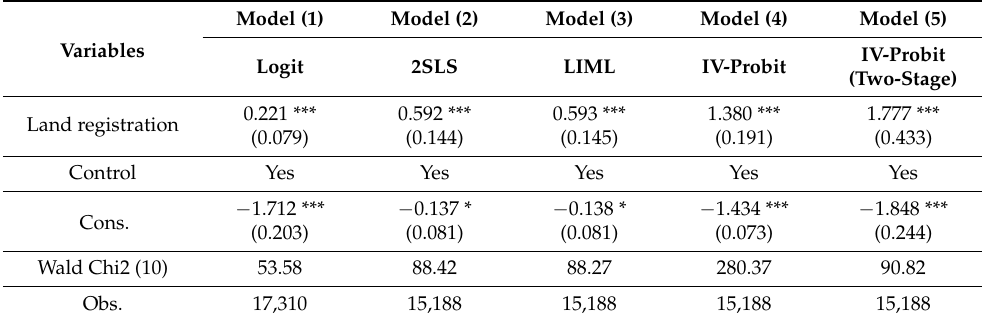
Table 6. Instrumental variable